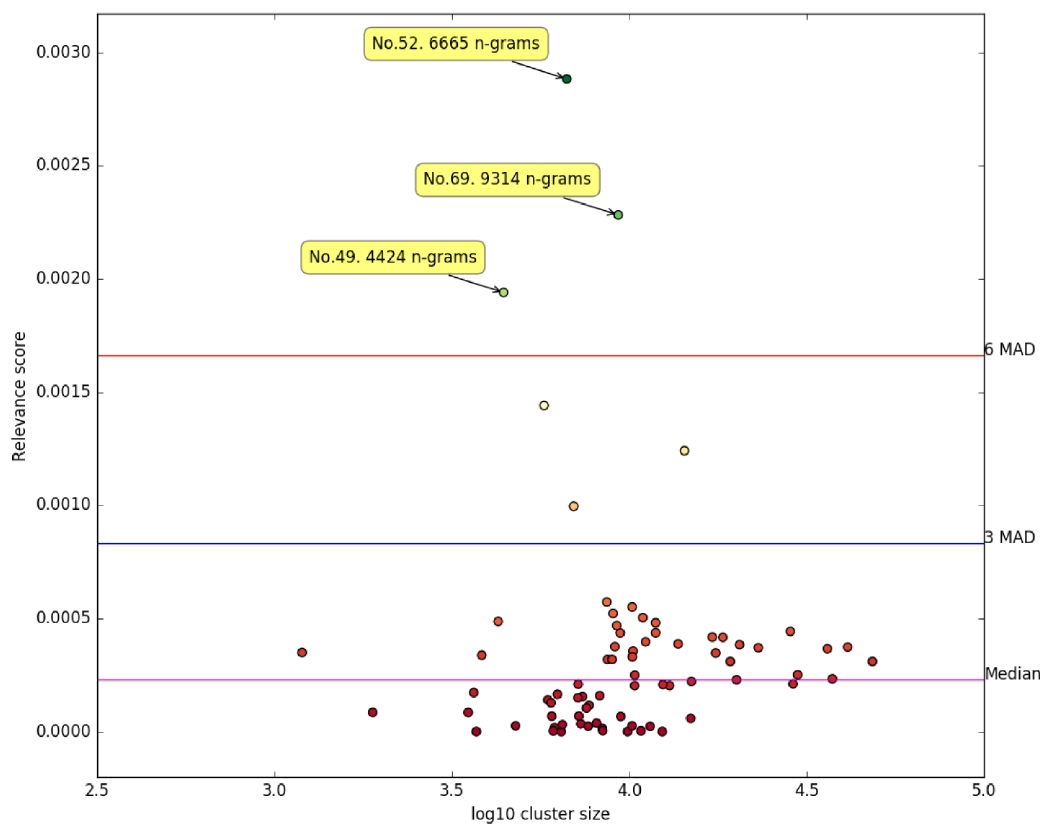
Figure 3. Scoring of clusters according to known symptomatology content. Each dot represents a unique cluster. The unique cluster IDs of the most relevant clusters according to our scoring algorithm are labelled.